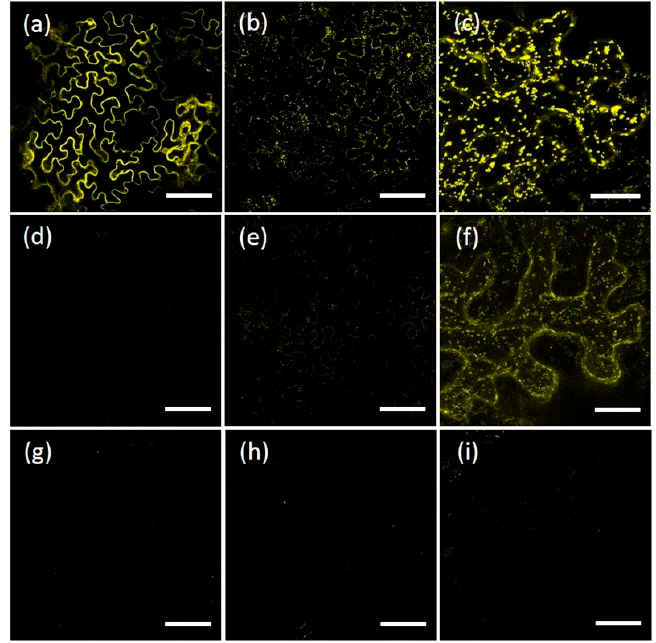
Figure 8. Dimerization of AtRMRs tested by BiFC. Confocal images of epidermal cells expressing split- YFP constructs: ( a ) The positive control, p6-nYFP and p6-cYFP; ( b , c ) AtRMR2 Δ RingSer-nYFP and AtRMR2 Δ RingSer-cYFP; ( d ) AtRMR1 Δ Ring-nYFP and AtRMR1 Δ Ring-cYFP; ( e – f ) AtRMR2 Δ RingSer- nYFP and AtRMR1 Δ Ring-cYFP; ( g ) negative control, AtRMR2 Δ RingSer-nYFP alone; ( h ) negative control, AtRMR2 Δ RingSer-cYFP alone; and ( i ) negative control, AtRMR2 Δ RingSer-nYFP and p6-cYFP. Singles images showing an overview of leaf tissue expressing the indicated fusion proteins ( a , b , d , e , g – i ), excepted stacked confocal images showing the localization in punctate structures of AtRMR2 Δ RingSer homodimers and AtRMR2 Δ RingSer-AtRMR1 Δ Ring heterodimers in a single epidermal cell, respectively ( c , f ). YFP signal ( a – i ). Scale bars = 100 µm ( a , b , d , e , g – i ); 30 µm ( c , f ).